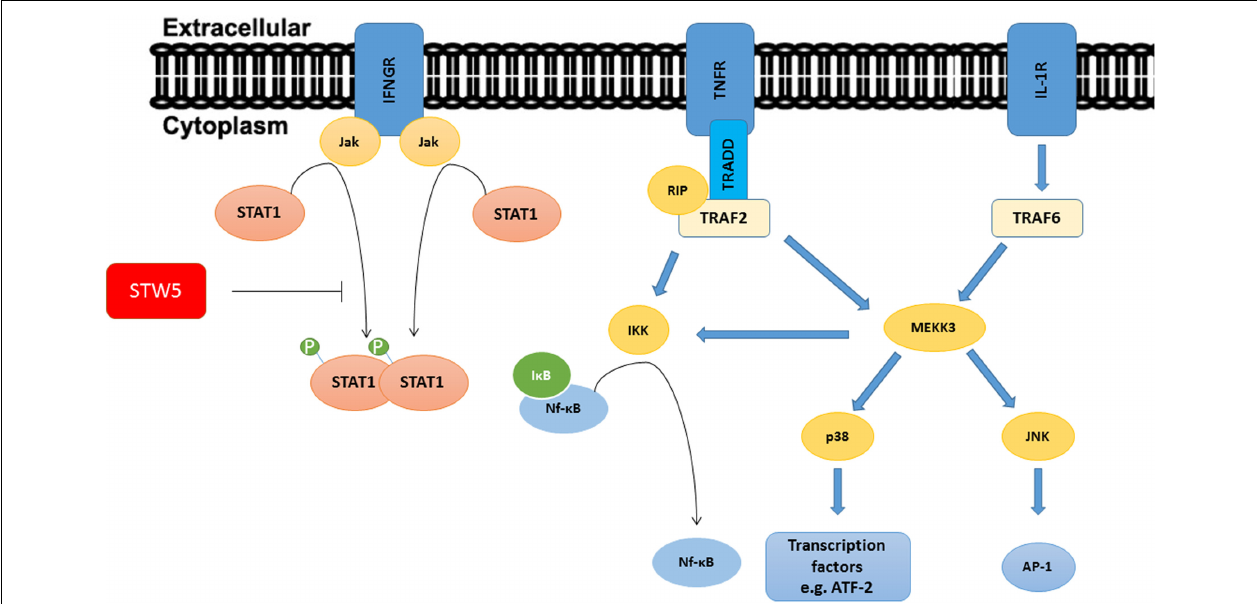
FIGURE 9 | Signaling pathways of TNF- α , IL-1 β , and IFN- γ : The picture shows a simplified representation of the involved pathways. Recruitment and activation of adaptor proteins lead to the activation of Transcription factors. STW5 and STW5-II reduced the phosphorylation of Stat1.